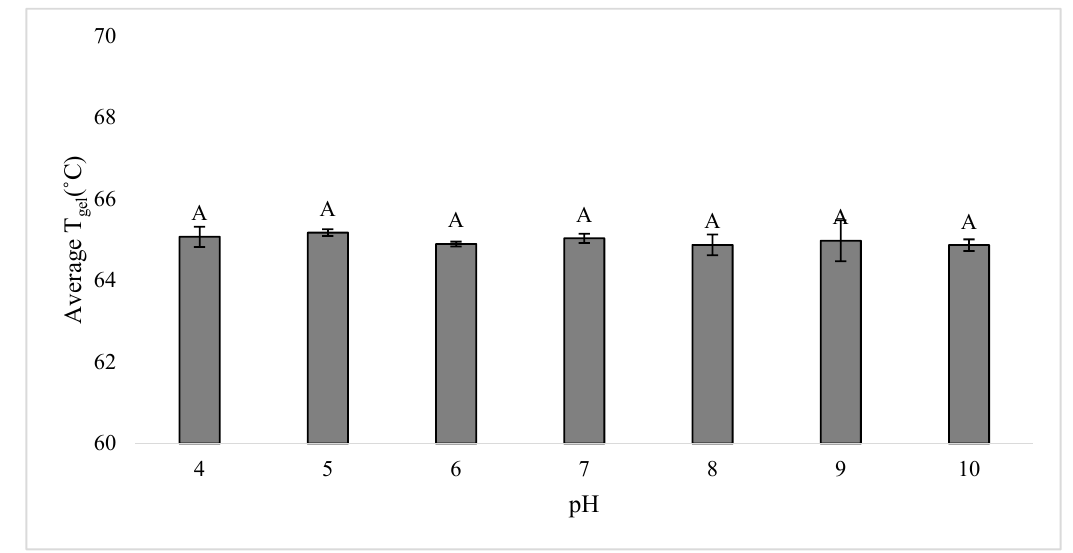
Figure 5. The onset T gel s of potato starch in 1 M glucose solutions at pHs 4, 5, 6, 7, 8, 9, and 10. Error bars are 1 standard deviation, n = 3, and the capital letters indicate significant differences in T gel s.